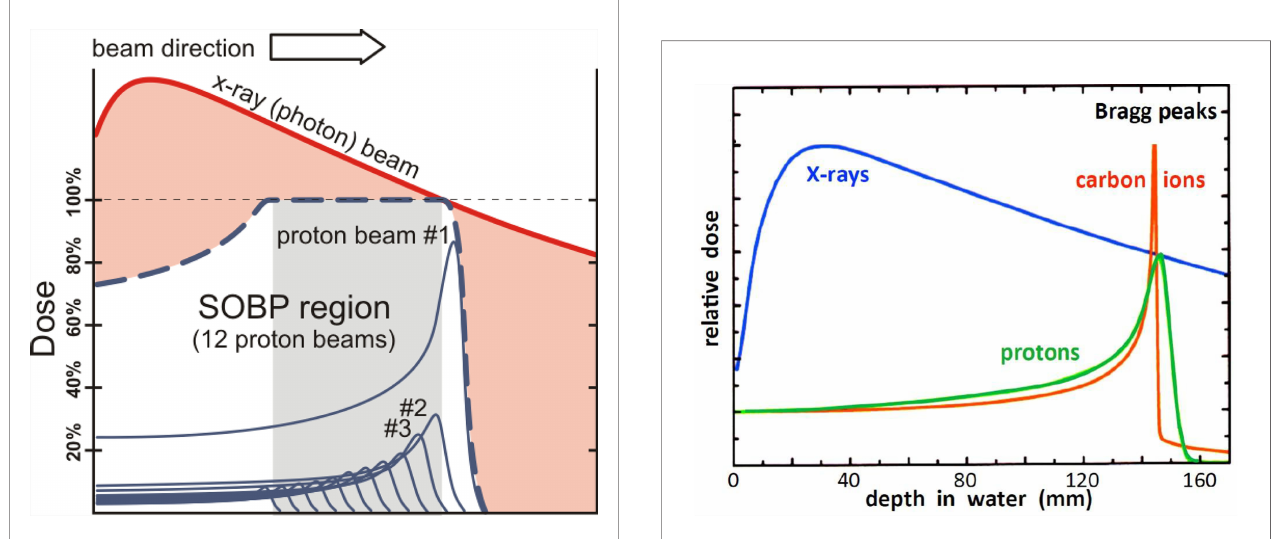
FIGURE 1 | Photons versus protons showing entrance and exit doses and the spread-out Bragg peak (SOBP) – after W.P. Levin et al. (13).